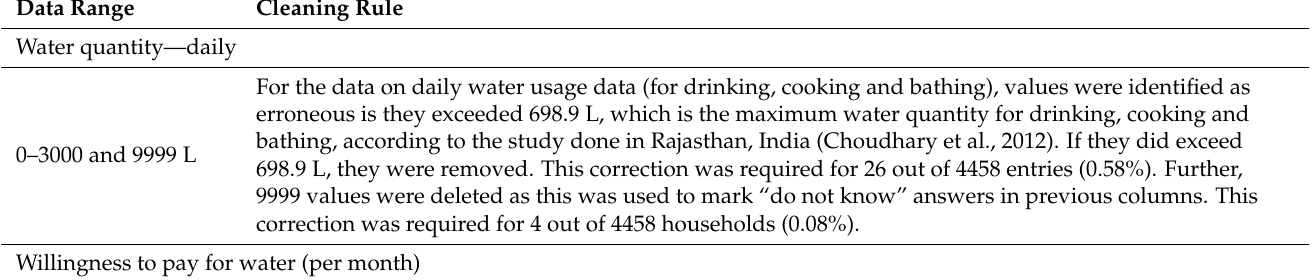
Table A1. Cleaning rules for numerical data.